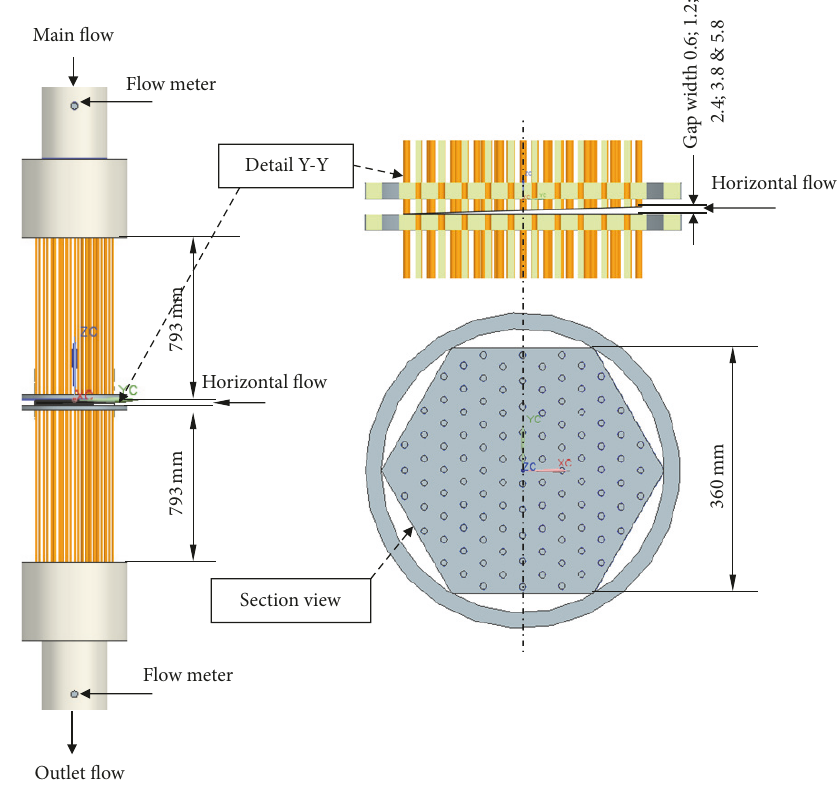
Figure 1: Simulation